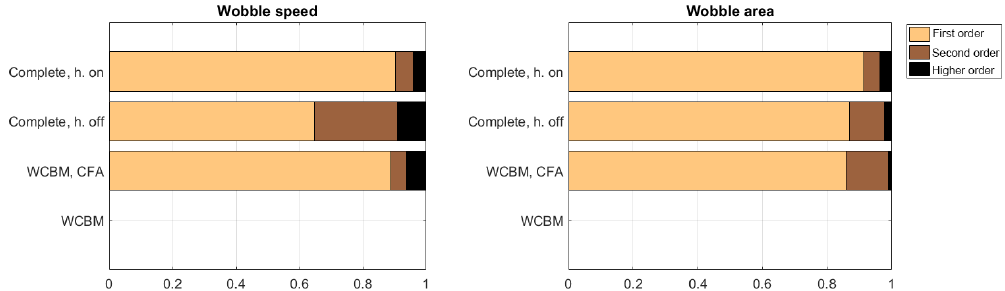
Figure 8. Sensitivity of the wobble mode to first, second, and higher orders of interaction. Models of increasing complexity from bottom to top.